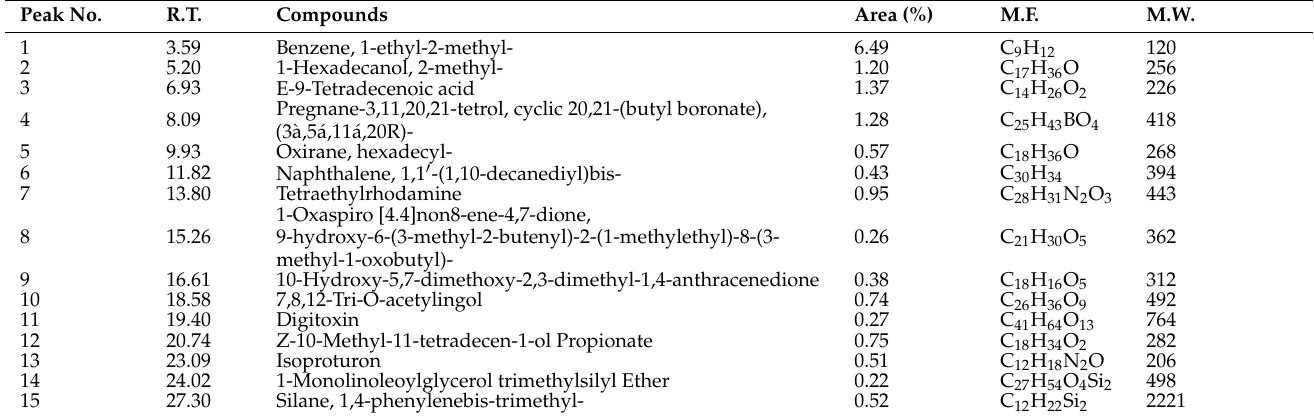
Table 7. Chemical composition of the methanolic extract of Sophora mollis leaves and flowers. Peak No.